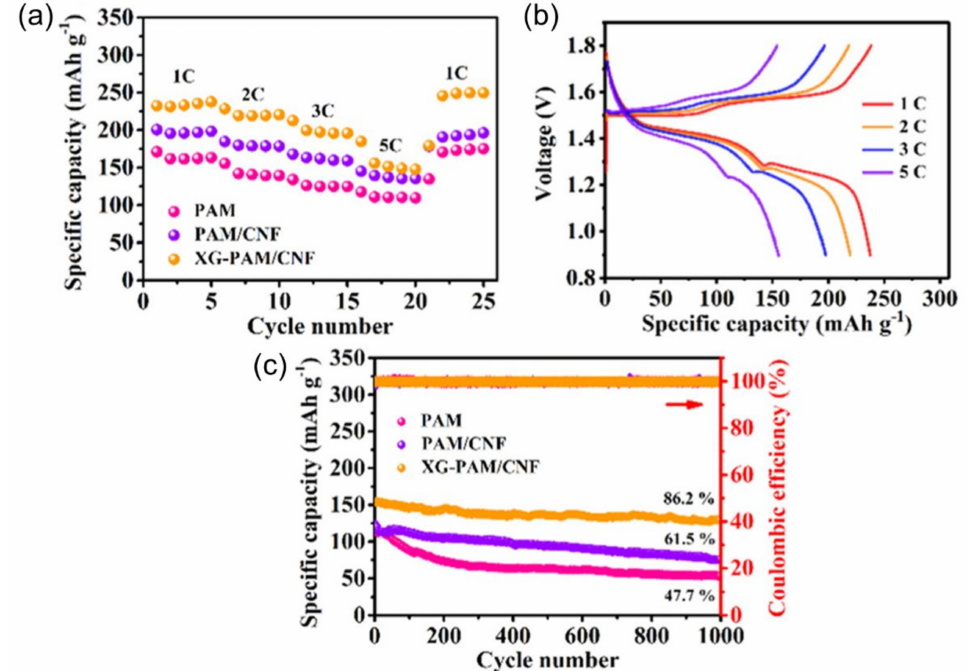
Figure 15. ( a ) Rate capacity of the flexible ZIBs at different rates and ( b ) corresponding charge– discharge curves of the XGPAM/CNF hydrogel. ( c ) Long-term cycle behavior and the corresponding coulombic efficiency of the flexible ZIBs at 4 C. Reprinted with permission from Ref. [102]. Copyright 2020 American Chemical